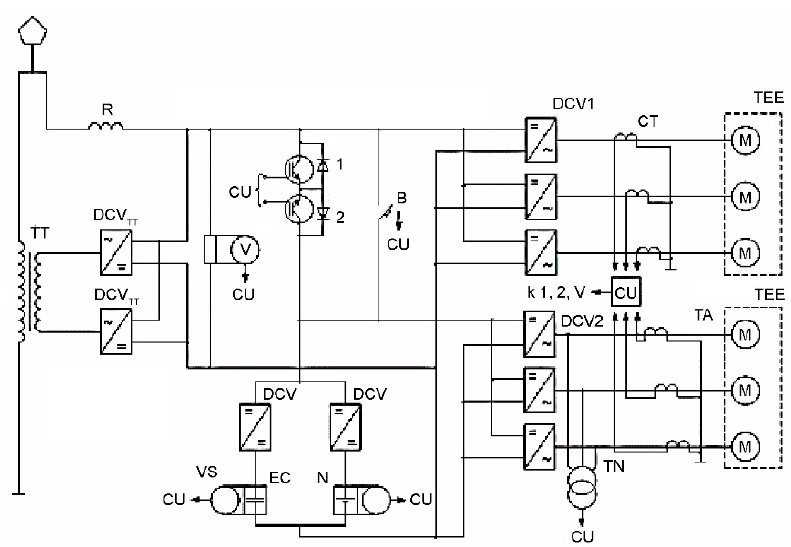
Figure 4. Schematic diagram of a power plant with hybrid energy storage.